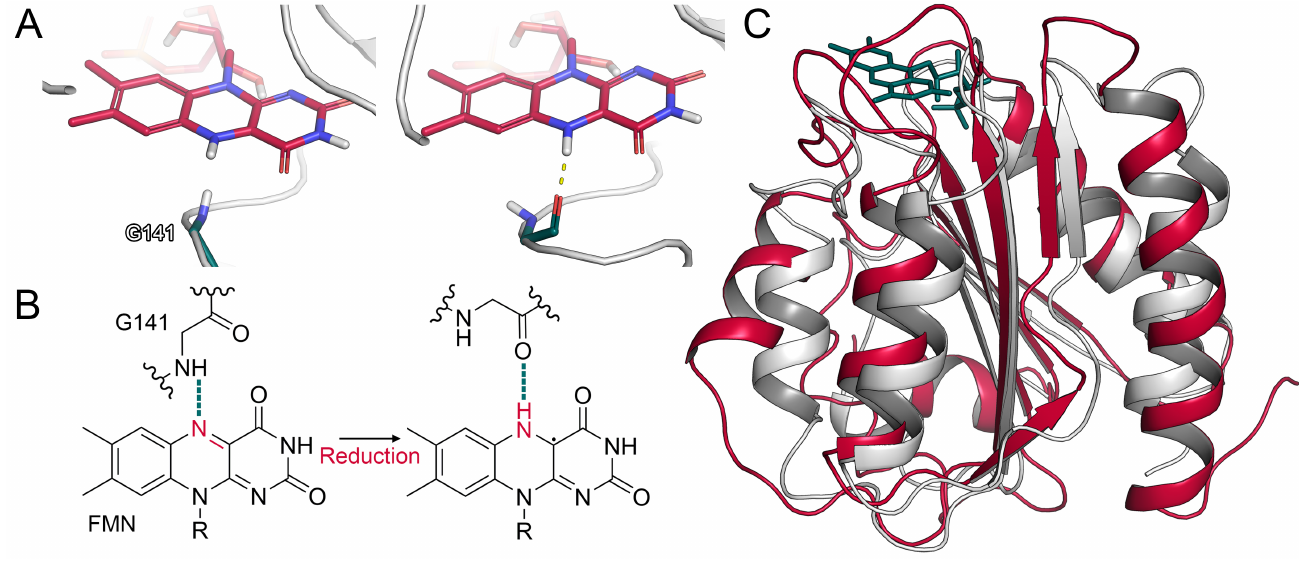
Figure 2. Conformational changes in the CPR and CPR–CYP2D6 complex. ( A ) Glycine flip in a simulation of FAD ox /FMN hq . ( B ) Schematic representation of glycine flip. ( C ) Superposition of CPR FMN domain and a flavodoxin (PDB ID: